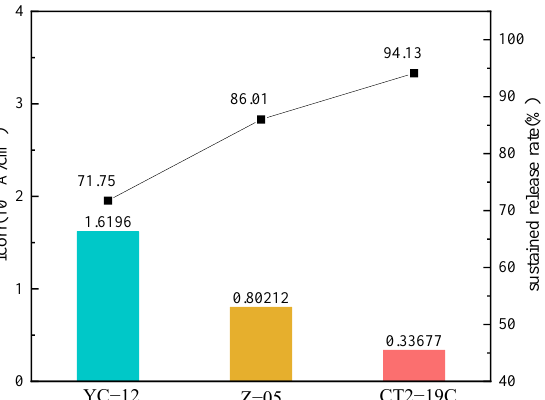
Figure 7. Self-corrosion current density and corrosion inhibition rate of P110ss steel in simulated corrosive water with three corrosion inhibitors YC − 12, Z − 05 and CT2 − 19C.